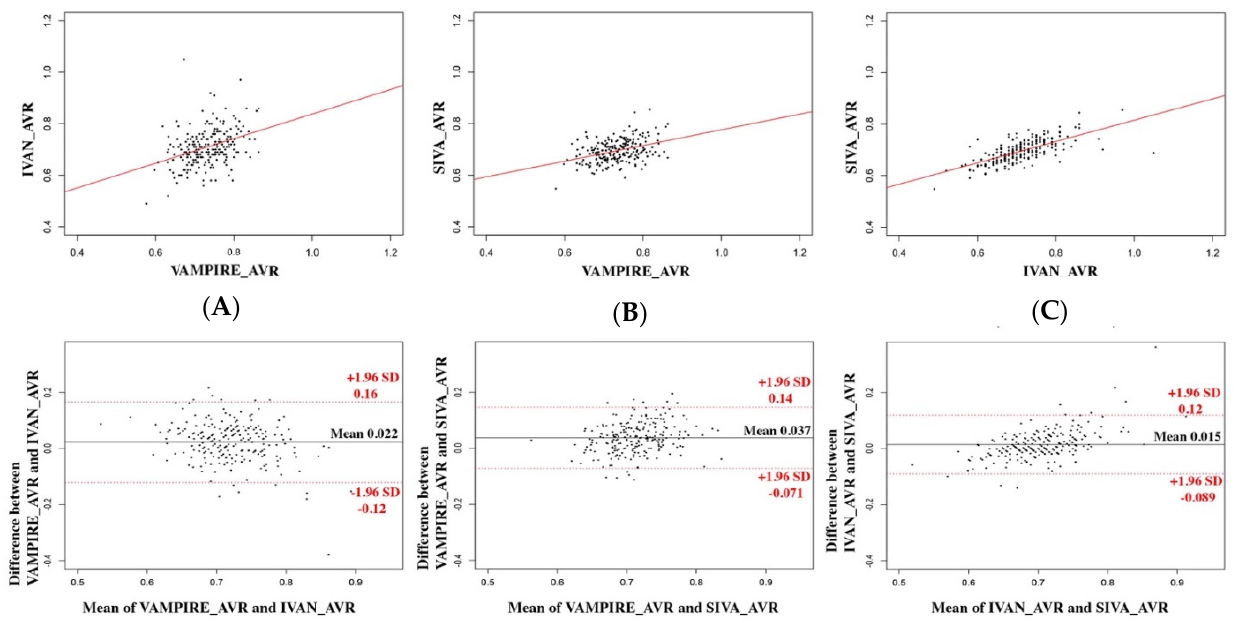
Figure 4. Agreement between each software for AVR. The three software applications are compared two by two: ( A ) IVAN and VAMPIRE, ( B ) SIVA and VAMPIRE, ( C ) SIVA and IVAN. Scatterplots are represented above with regression lines; Bland–Altman plots are represented below. Statistical relationships are summarized in Table 3.